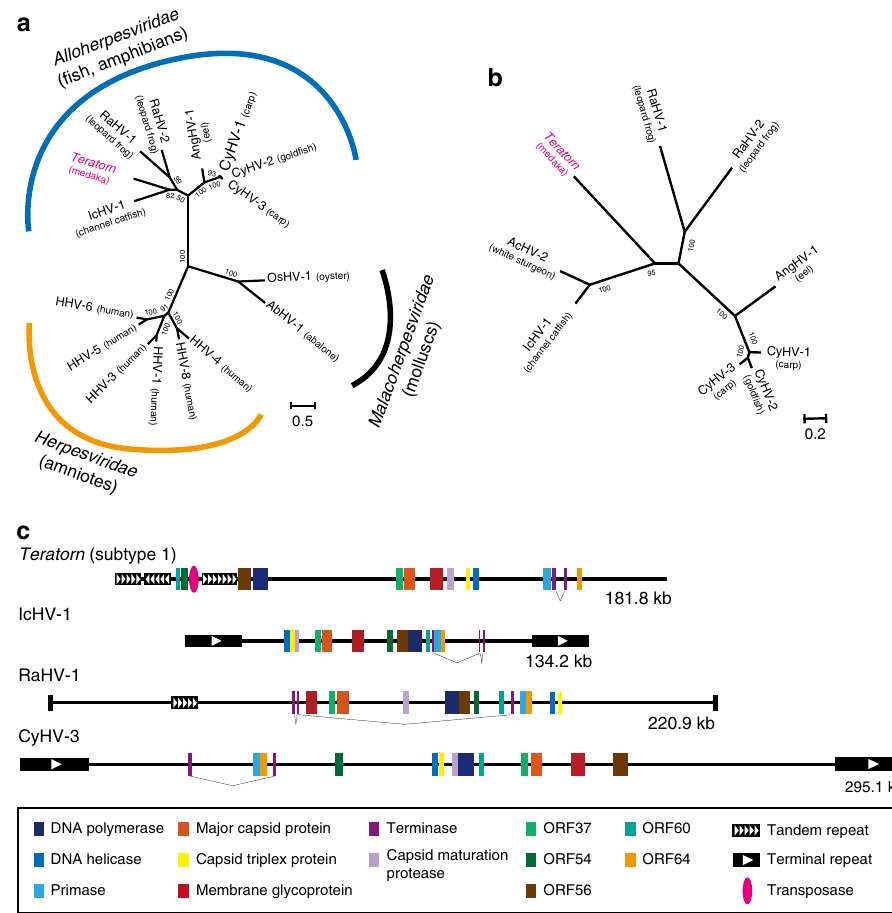
Fig. 2 Teratorn contains a full herpesvirus genome. a Maximum-likelihood tree based on the amino-acid sequence of the DNA packaging terminase gene, the only gene con fi dently conserved among all herpesvirus species. Bootstrap values of branching are indicated at the nodes. Note that, among the three families ( Herpesviridae , Alloherpesviridae , and Malacoherpesviridae ) in the Herpesvirales order, Teratorn belongs to the family Alloherpesviridae (infecting fi sh and amphibians). b Maximum-likelihood tree based on the concatenated amino-acid sequences of major capsid protein, DNA helicase, DNA polymerase, and DNA packaging terminase from all alloherpesvirus species with sequenced genome. Within Alloherpesviridae, Teratorn is only distantly related to any other species. c Comparison of genomic structure of subtype 1 Teratorn and several alloherpesvirus species, as representatives of genera in the family Alloherpesviridae . The colored squares indicate each herpesvirus core gene, and black boxes depict repeat sequences. Note that Teratorn contains all 13 core genes conserved among all alloherpesvirus species, as well as long repeats. The scale bars in b and c represent the number of substitutions per